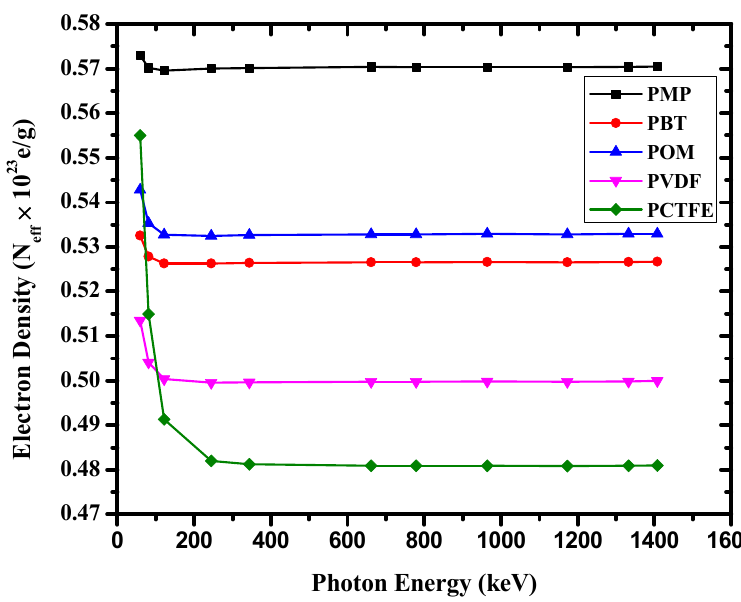
Figure 8. The variation of N eff with γ-ray energy for the investigated polymers.